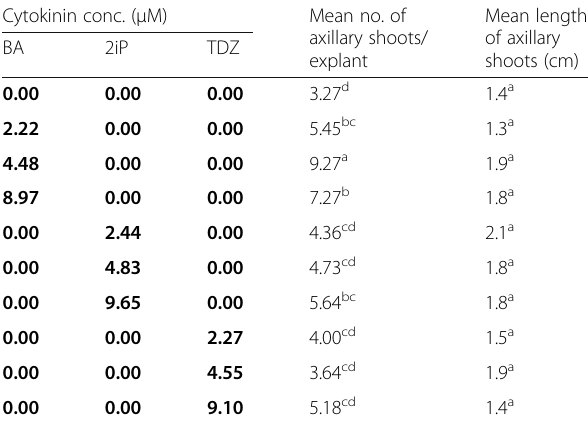
Table 2 Effect of Murashige and Skoog (MS) medium supplemented with 6-benzyl adenine (BA), N6-(2-isopentenyl) adenine (2iP), or thidiazuron (TDZ) on the in vitro multiplication of Silene schimperiana axillary shoots Cytokinin conc. ( μ M)